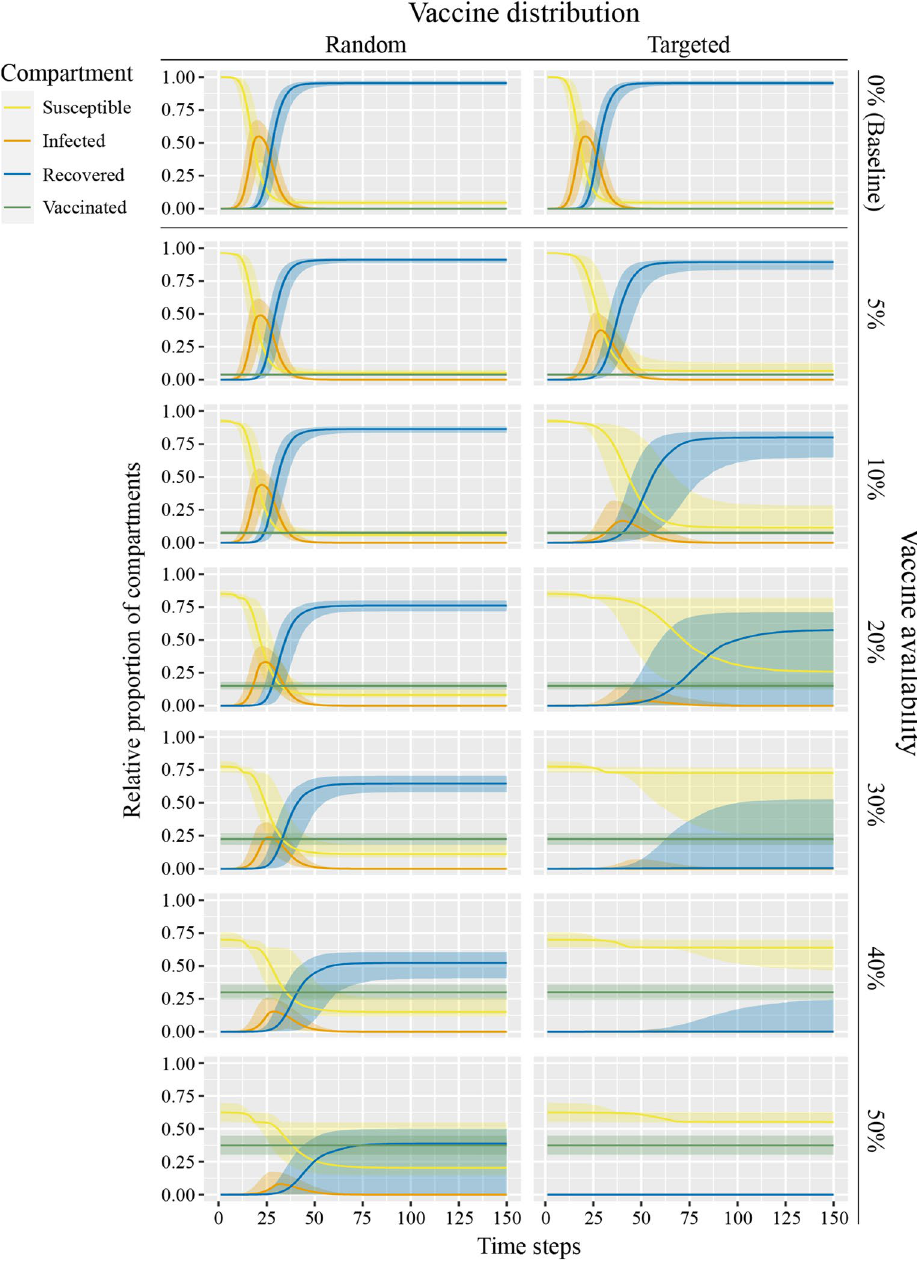
Figure 4. SIRV plots for vaccine availability per vaccination campaign condition. Solid lines show median proportion (y-axis) of susceptible (yellow), infected (orange), recovered (blue), and successfully vaccinated/ immunized (green) agents over the first 150 simulated time steps. Ribbons show interquartile